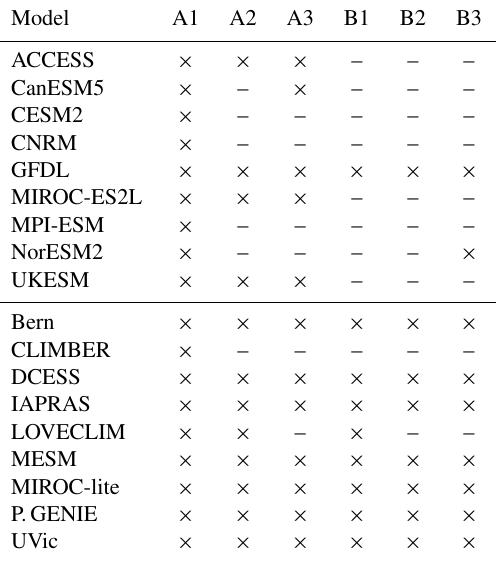
Table 2. Experiments conducted for ZECMIP by model. Full ESMs are listed on top, followed by